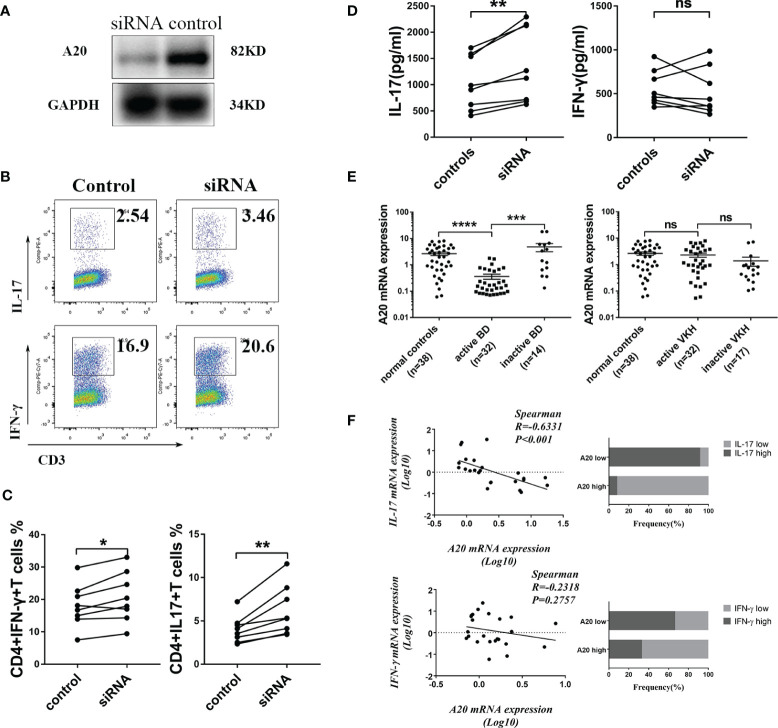
A20 expression was decreased in CD4+T cell from BD patients and A20 knockdown shifted CD4+T cells toward Th1 and Th17 phenotype. (A) Immunoblot showing A20 protein inhibition in CD4+T cells treated with A20 siRNA. (B) Representative dot plots gated on CD4+ T cells showing IFN-γ and IL-17 expression. (C) FACS analysis of the IL-17A expression in activated CD4+ T after A20 was inhibited by siRNA (n=8). (D) The production of IL-17 and IFN-γ by A20 knockdown CD4+T cells was tested by ELISA (n=8). (E) The mRNA expression of A20 in CD4+T cells from BD patients and VKH patients was tested by RT-qPCR. (F) Spearman’s rank correlation coefficient of mRNA expression of A20 vs IL17 and A20 vs IFN-γ (n=24). Data are shown as mean ± SD. One-way ANOVA, Spearman test, Mann Whitney test and paired -T test was used, ns p>0.05, *p<0.05, **p<0.01, ***p<0.001, ****p<0.0001.